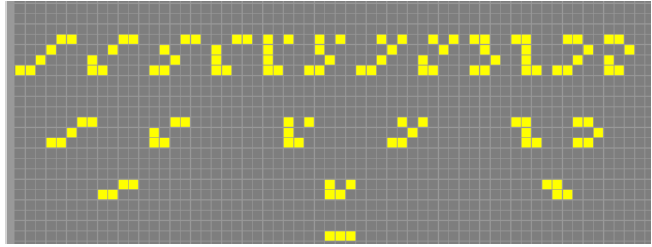
Figure 13. Cellular automata with less than six external